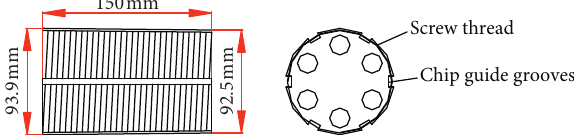
Figure 6: Structure optimization scheme of the constant resistance body. Table 3: Structural optimization experiment scheme of the con- stant resistance body.